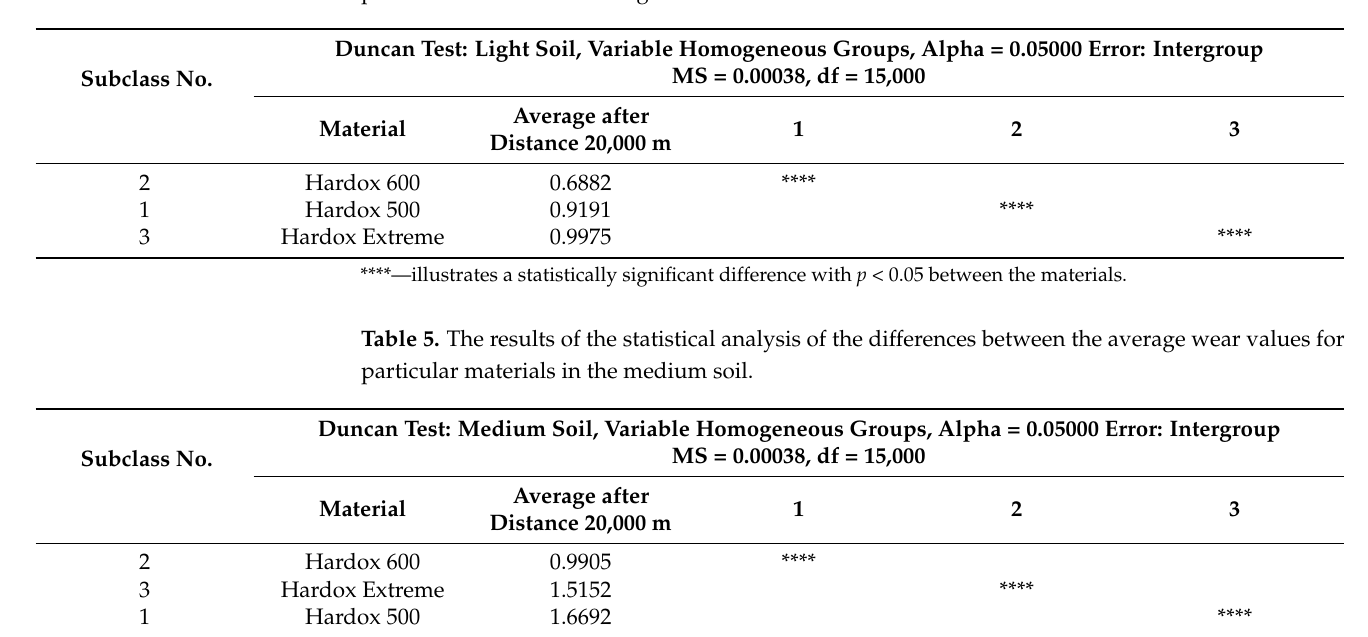
Table 4. The results of the statistical analysis of the differences between the average wear values for particular materials in the light soil.